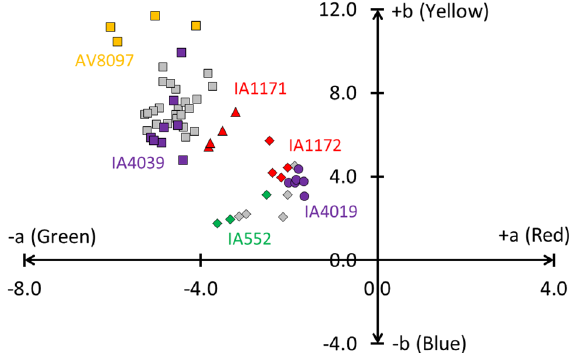
Figure 7. The colour values of the roundels show that the earlier roundel material (IA552, IA1172 and IA4019) is purer compared with the later material (IA4039 and AV8097). The following symbol code was applied: early 16th c. (diamond), mid-16th c. (circle), late 16th c. (triangle), and 17th c. (square). The colour filling of the symbols represent the location of origin: Antwerp (red), Brussels (green), Leuven (purple) and undefined (orange). The colour coordinates of the Middelburg material are plotted in